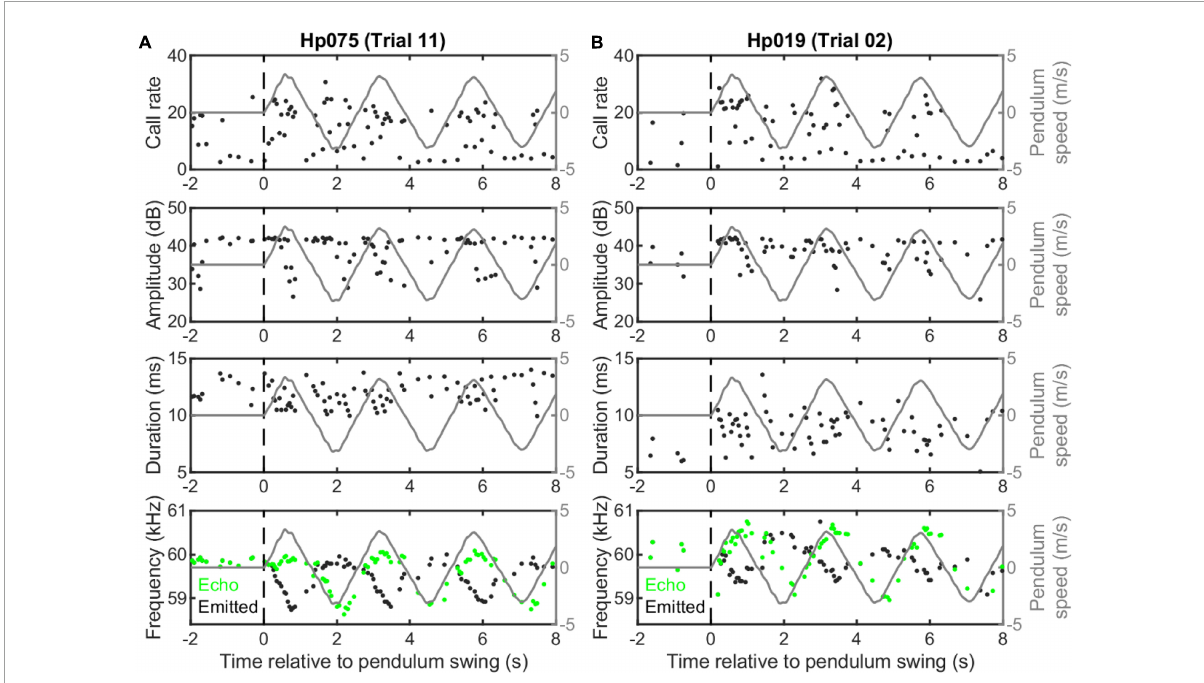
FIGURE3 Example echolocation behavior of two individuals of Hipposideros pratti swung on a pendulum setup. Two trials illustrating higher (A) and lower (B) quality Doppler shift compensation (DSC) performance of the two bats, as judged by the compensation magnitude and echo-frequency variation. Note, both bats compensated for the Doppler effect by lowering the emitted call frequency only for the forward, but not the backward swings. Also, there were no clear cyclic adjustments of call rate, call amplitude, or call duration during the